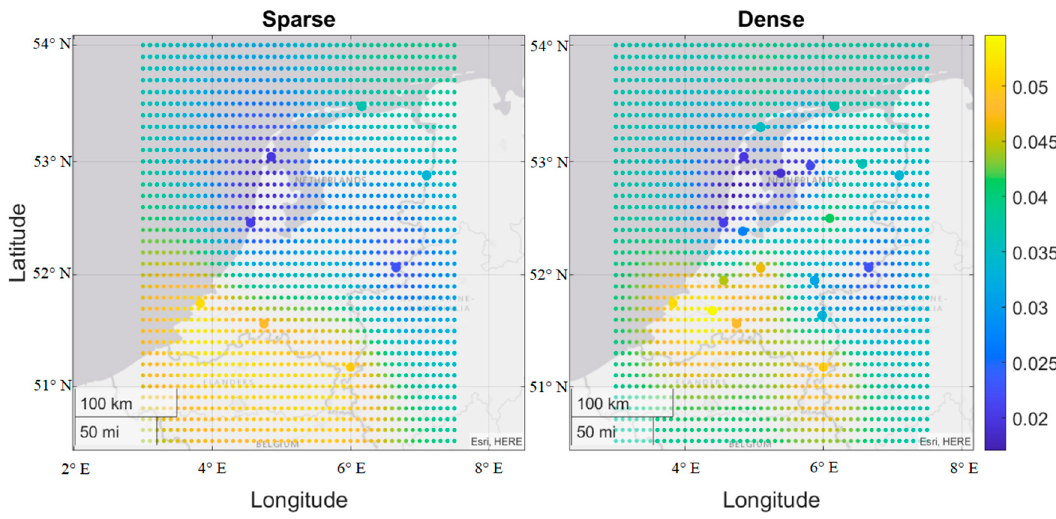
Figure 7. Values of the predicted zenith wet delays at particular locations (the smaller circle) in the local area by using the sparse and dense network (the bigger circle) on 1 August 2019. The unit is m.